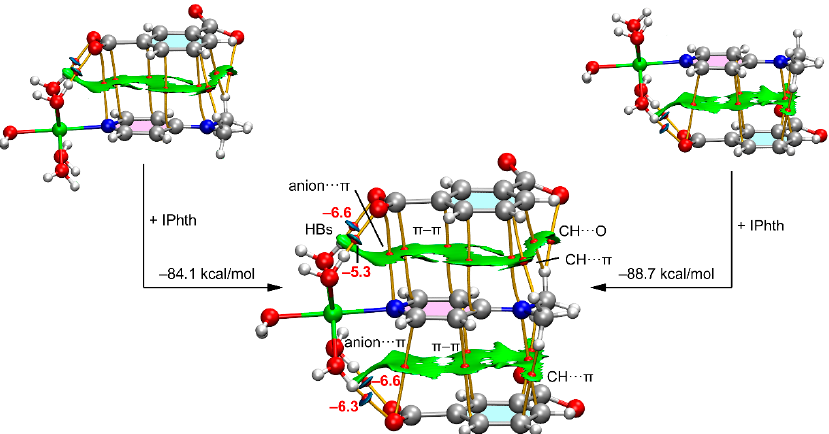
Figure 13. Combined QTAIM analysis (bond CPs in red, bond paths in orange) and NCI surfaces of two dimers of compound 1 (top) and the trimer (bottom). The gradient cut-off is ρ = 0.04 a.u., isosurface s = 0.5, and the color scale is − 0.04 a.u. < (sign λ 2 ) ρ < 0.04 a.u. Only intermolecular interactions are shown. The energies of the H-bonds are given in red adjacent to the bond CPs in kcal/mol. The formation energy of the trimer from the two dimers is also indicated.